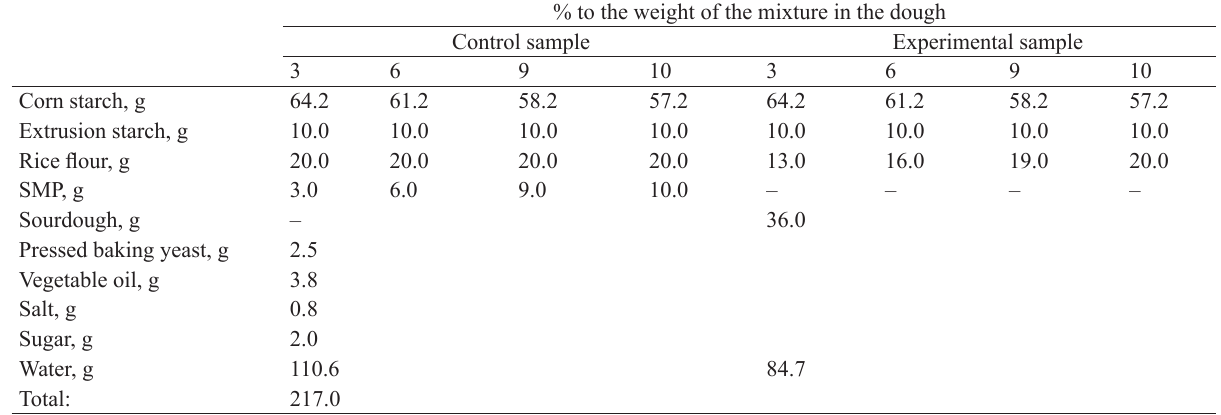
Table 4 Dough formulae Material Consumption of raw materials per 100 kg of the mixture with the SMP content, % to the weight of the mixture in the dough Control sample Experimental